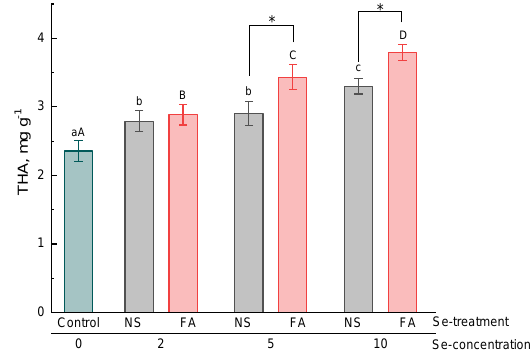
Figure 2. Effect of type and concentration of Se application on total hydroxycinnamic acid content (THA) in basil leaves.